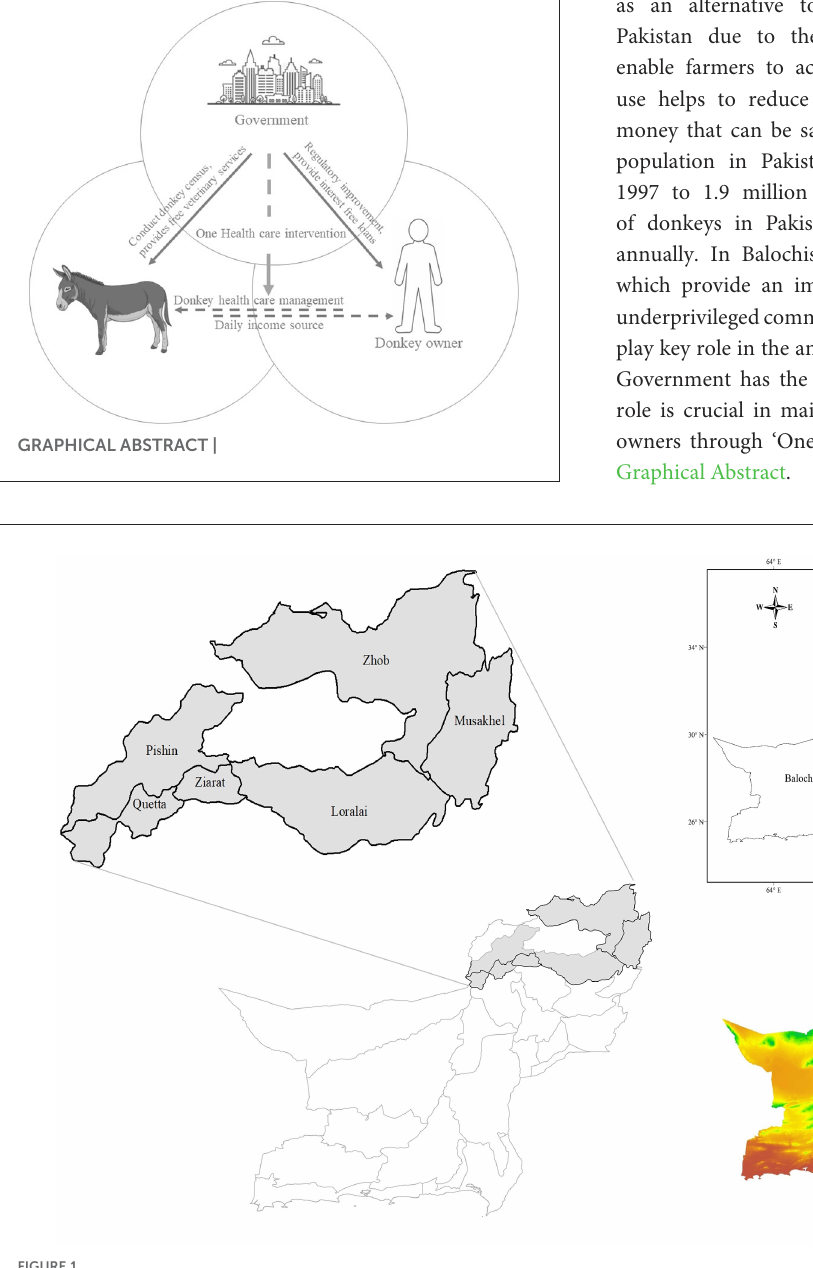
FIGURE1 Map of the selected districts of Balochistan province. (Left) The gray area represents the selected districts. (Right) The altitude map of Balochistan [source: Author mapped using the data retrieved from ArcGIS ® ArcMap software by Esri (ESRI, CA, USA), accessed on 15 September